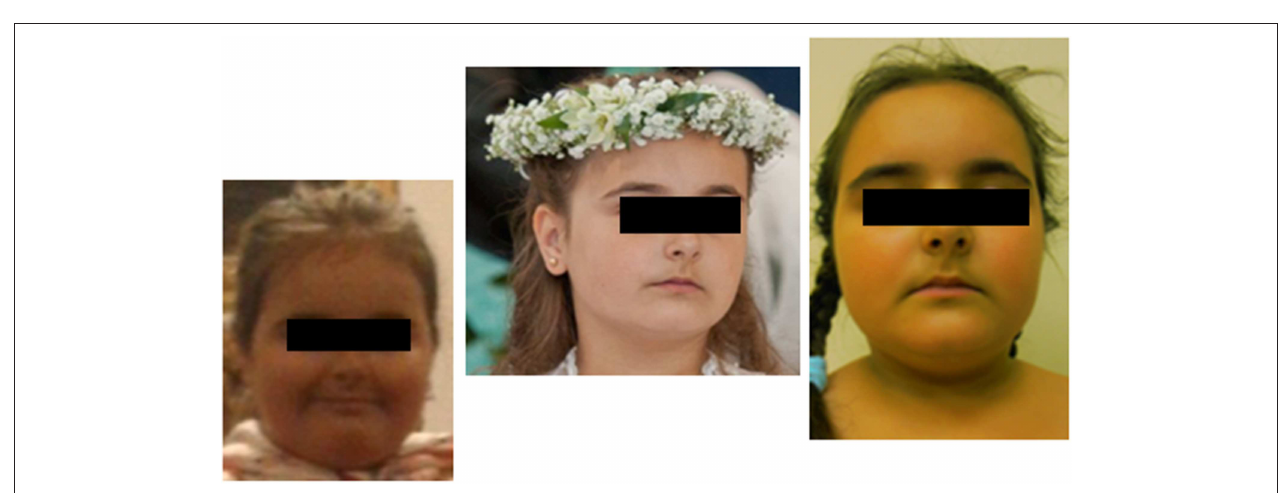
FIGURE 4 | MR image of the hypothalamic-pituitary area with contrast with visible pituitary adenoma in the patient with cyclic Cushing’s disease in the second relapse period (clinical and biochemical hypercortisolemia at the age of 8 6/12 years).